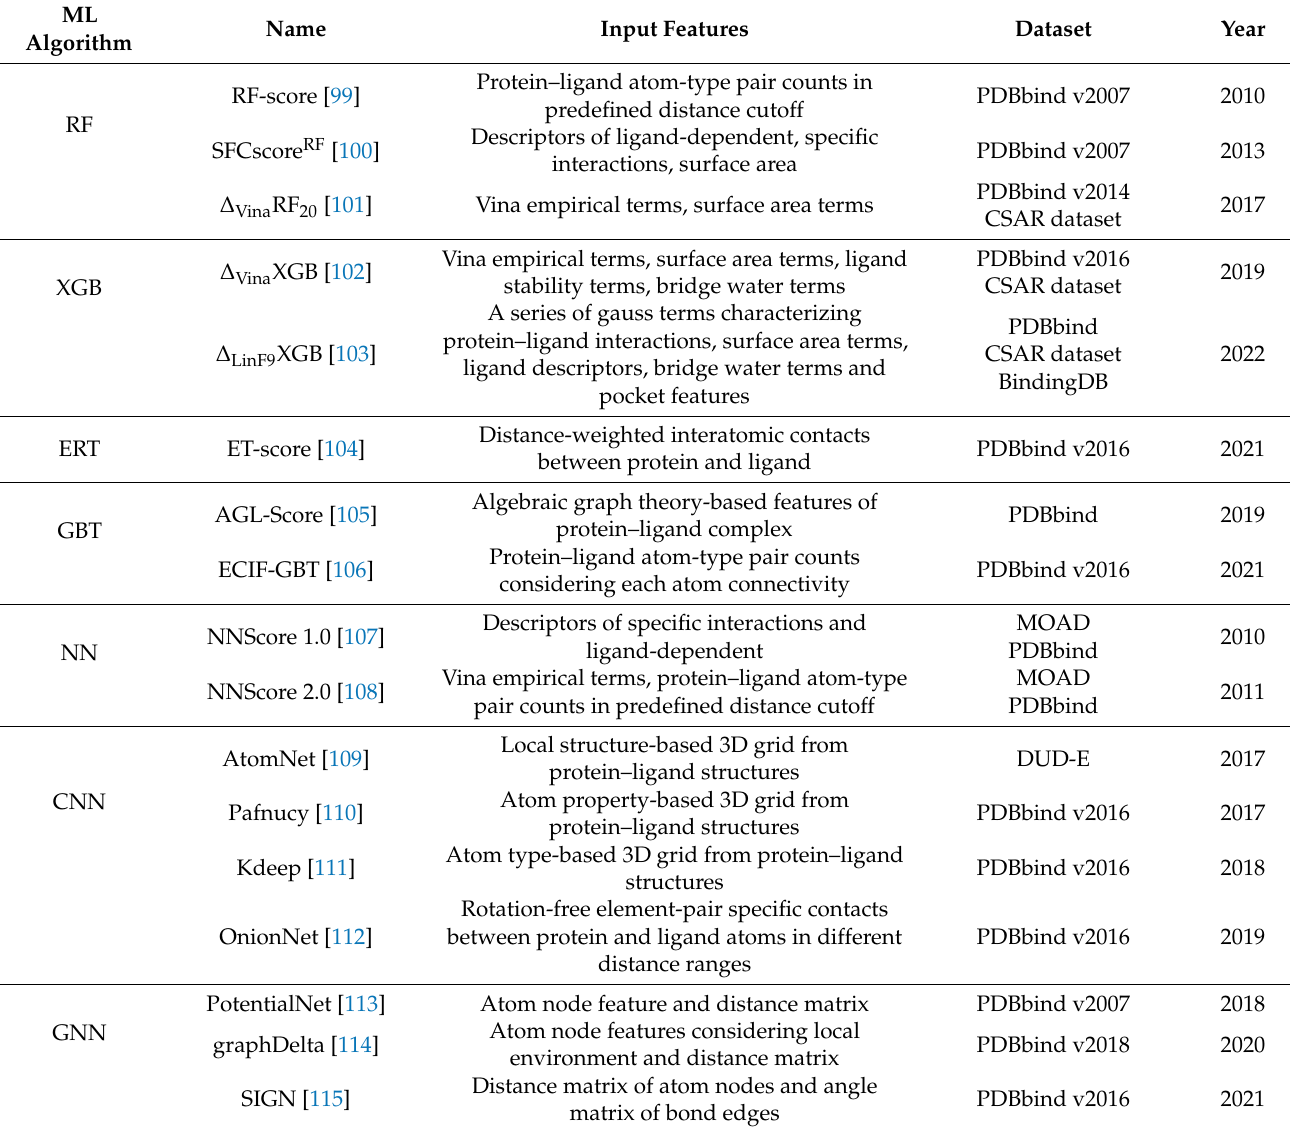
Table 1. Machine learning scoring